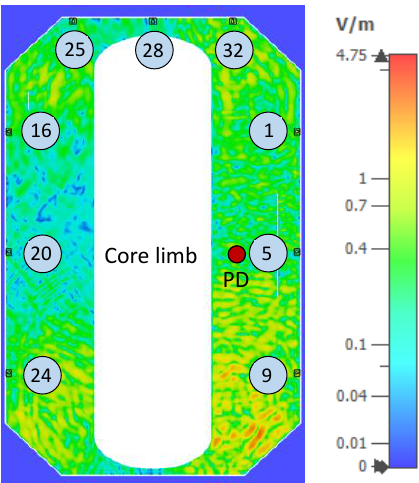
Figure 12. Electric field distribution on the first cutting plane at time t = 24 ns after PD source (red circle) trigger.